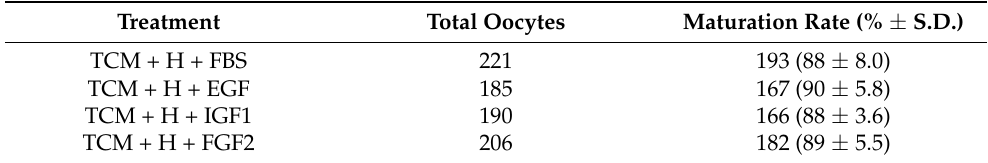
Table 2. Effect of EGF, IGF1 and FGF2 in defined TCM-199 maturation medium on the maturation rate of bovine